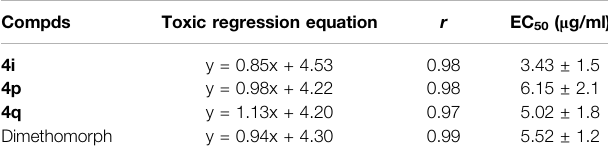
TABLE 2 | The EC 50 values of compounds 4i, 4p, and 4q against P.